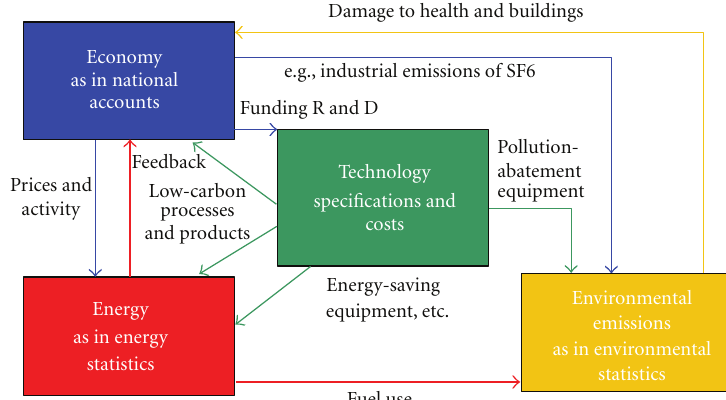
Figure 1: E3 interactions within E3MG.